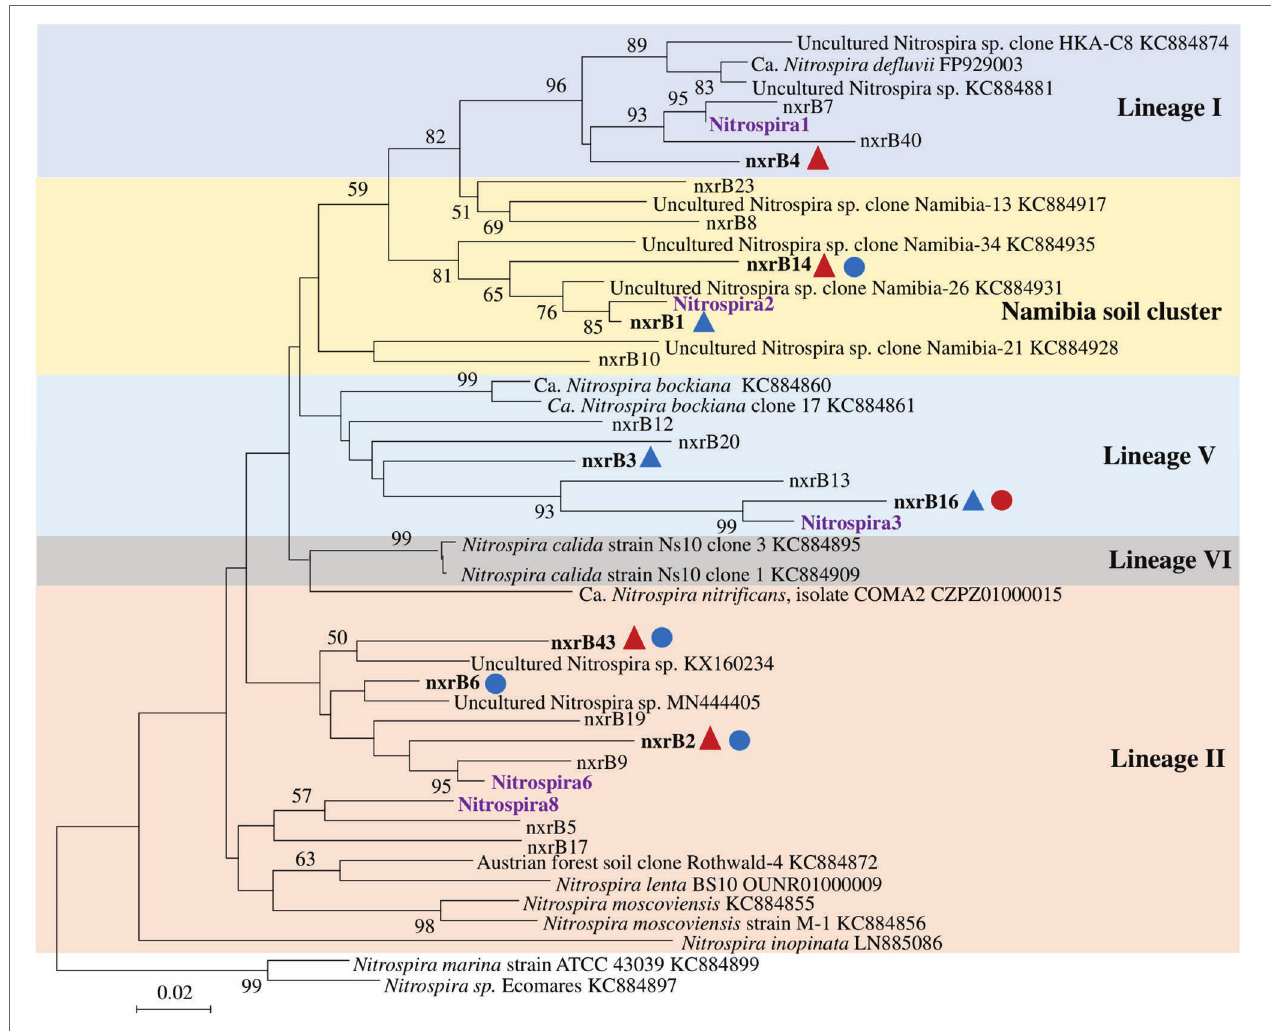
FIGURE 5 | Neighbor joining tree for Nitrospira partial nxrB top 20 OTUs (covered 94.9% of total sequences). The scale bar represents 1% nucleic acid sequence divergence, and bootstrap values (>50%) are showed at branch points. OTUs are shown in bold if they were significantly changed by N treatment. Up triangles indicate a significant difference between values for control and AS treatments, while circles indicate a significant difference between values of control and compost treatments. Red color indicates a significant higher abundance than control treatment, while blue color indicates a lower